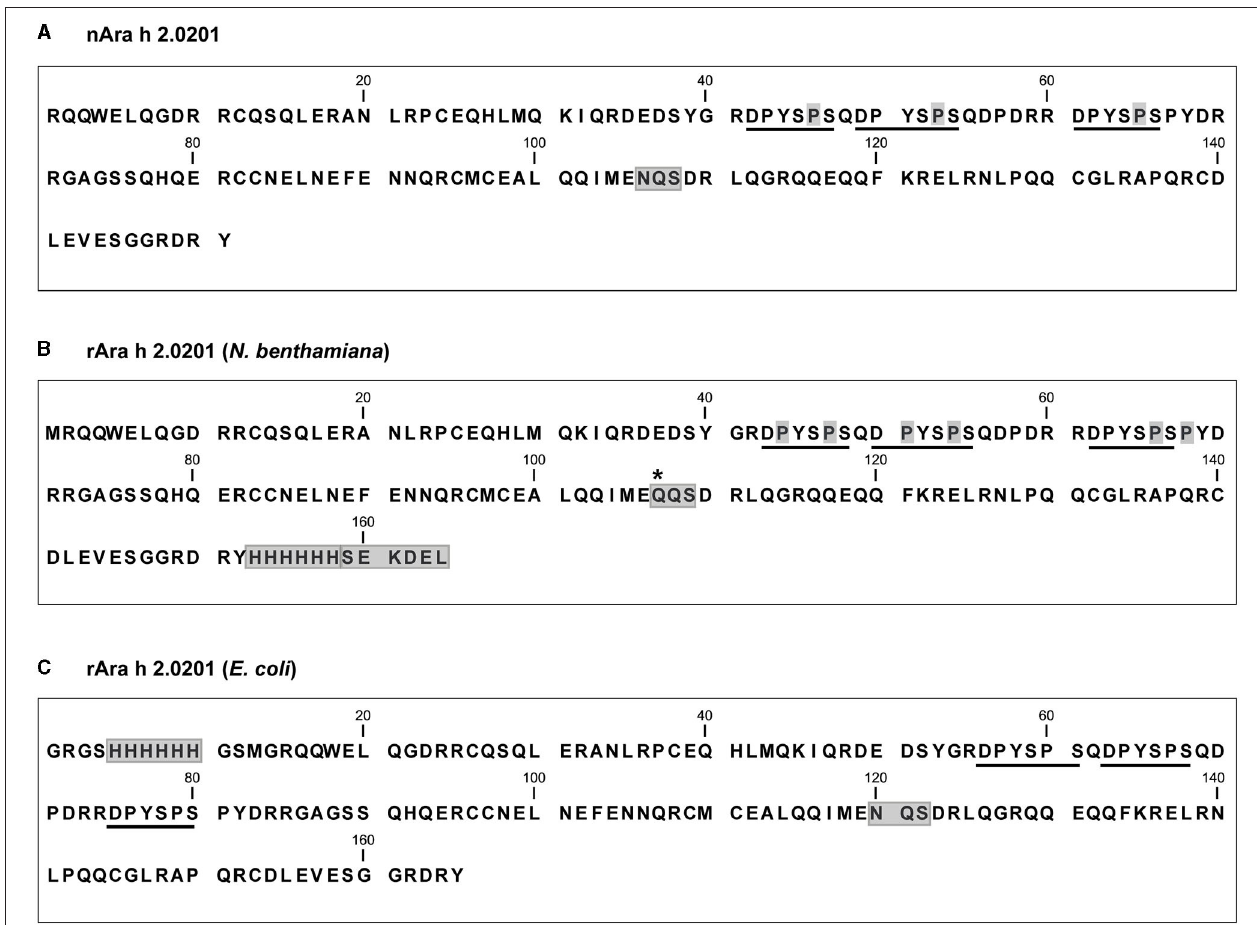
FIGURE 1 | Amino acid sequences of the Ara h 2 proteins used in this study. (A) Mature nAra h 2.0201. Naturally occurring hydroxyproline residues within the immunodominant IgE epitopes (underlined) are highlighted in gray. The canonical N-glycosylation site (NQS) is boxed. (B) rAra h 2.0201 used for expression in N. benthamiana , including a C-terminal hexa-histidine tag and an ER retention signal (SEKDEL, boxed). The canonical N-glycosylation site NQS was mutated to QQS (boxed), and the single amino acid substitution is marked with an asterisk. Mass spectrometry-detected and manually confirmed hydroxyproline residues are highlighted in gray. (C) rAra h 2.0201expressed in E. coli , including an N-terminal hexa-histidine tag (boxed). The canonical N-glycosylation site is boxed.